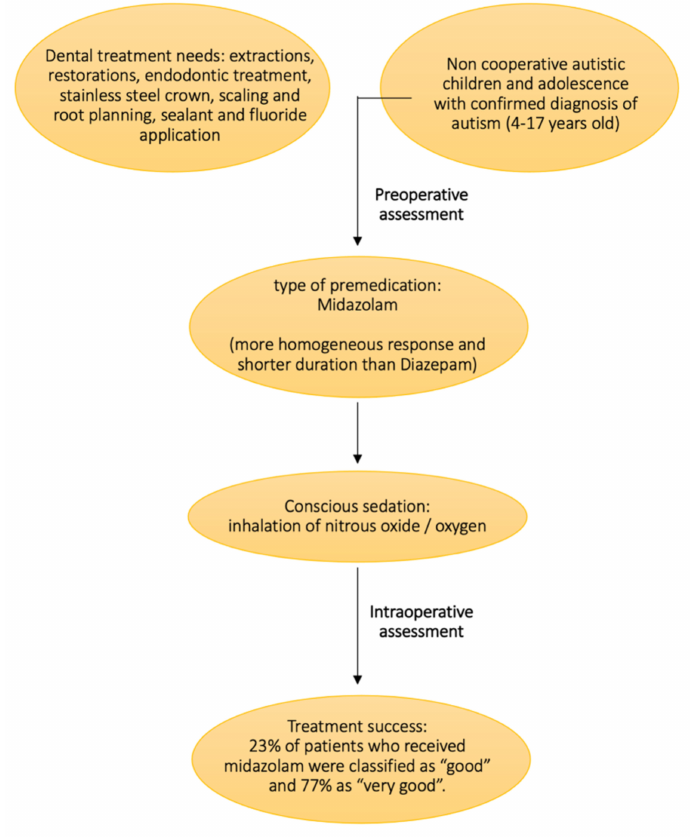
Figure 2. Representation of the